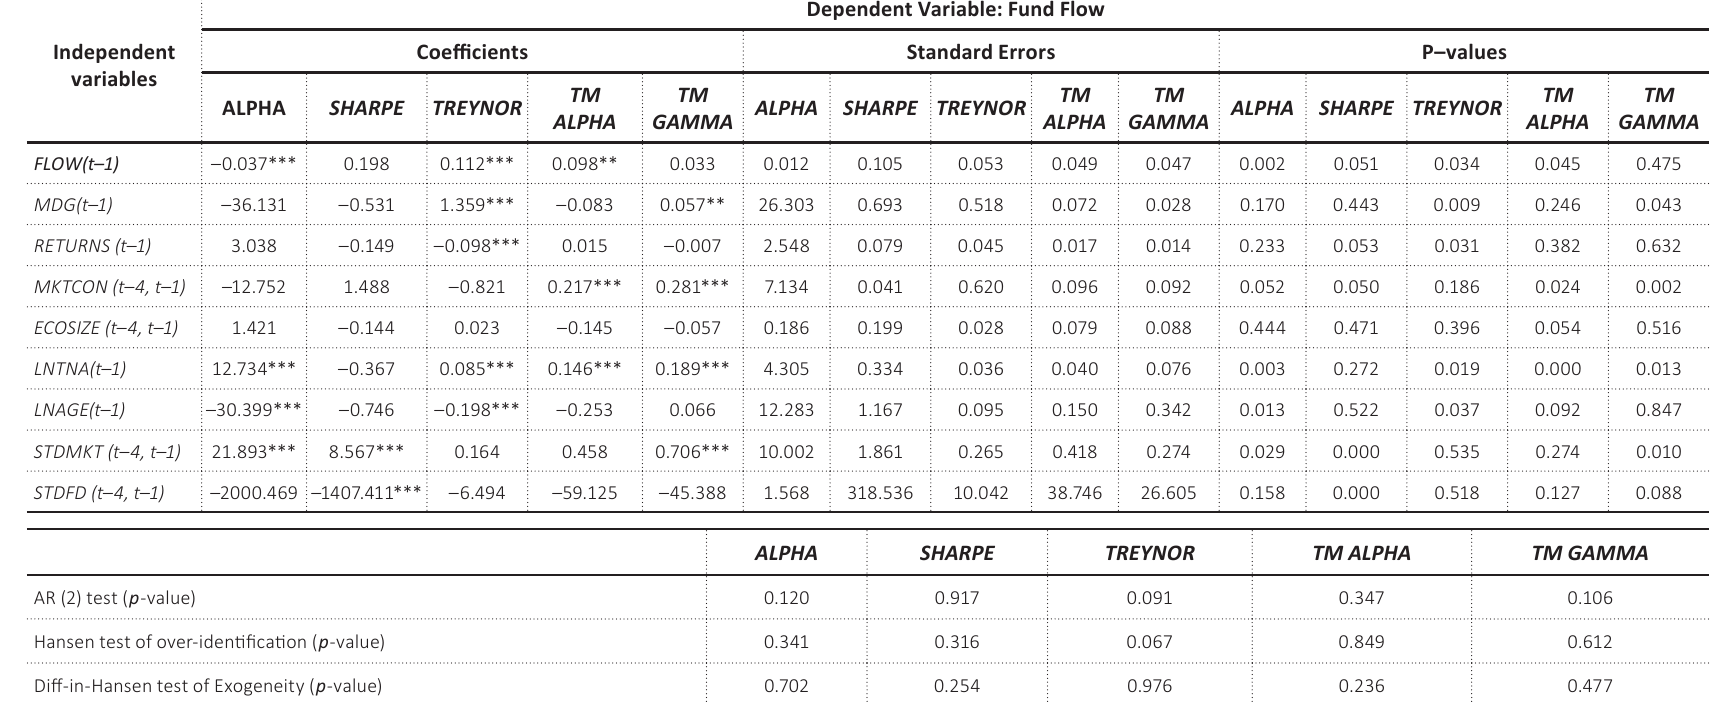
Table 3. Effect of performance manipulation on fund flows under different market conditions